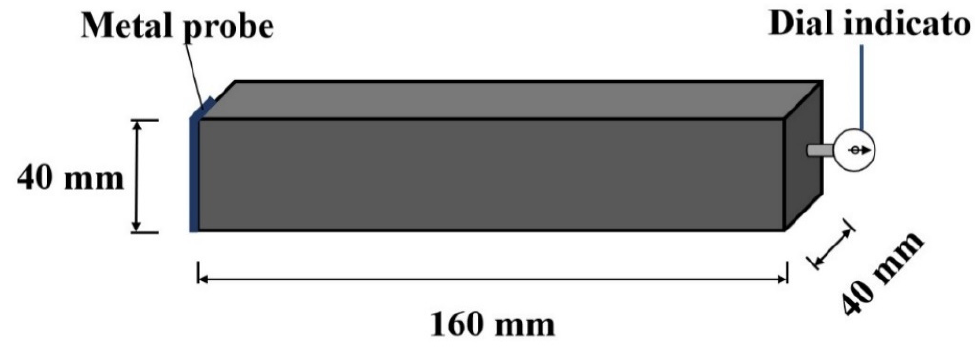
Figure 2. The measurement of dry shrinkage rate.